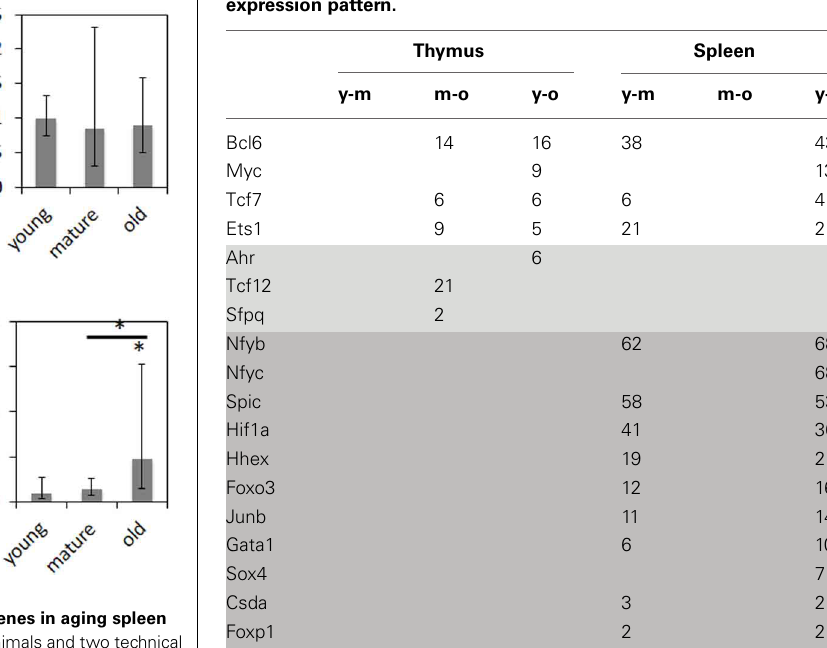
Table 3 | The correlation of transcription factor expression with gene expression pattern.